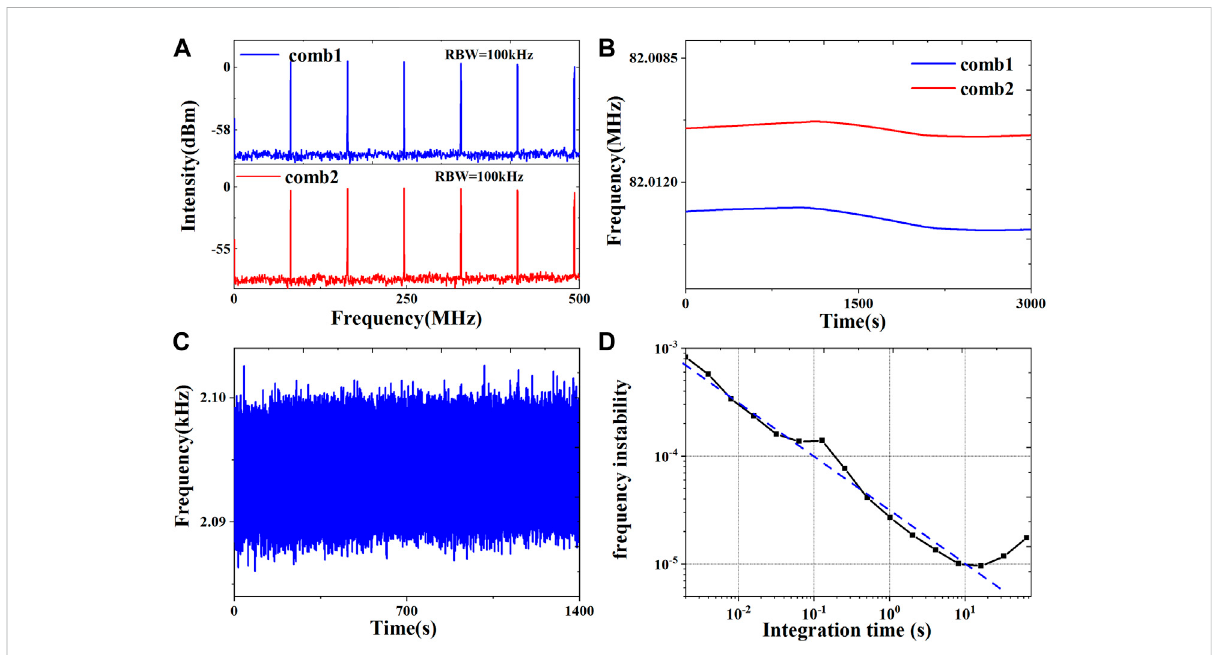
FIGURE 3 (A) RFspectraand (B) temporalvariationsatrepetitionratesofthetwofrequencycombs (C) Thefrequencyjitterofthe Δ f rep versus time (D) Allan deviation of Δ f rep